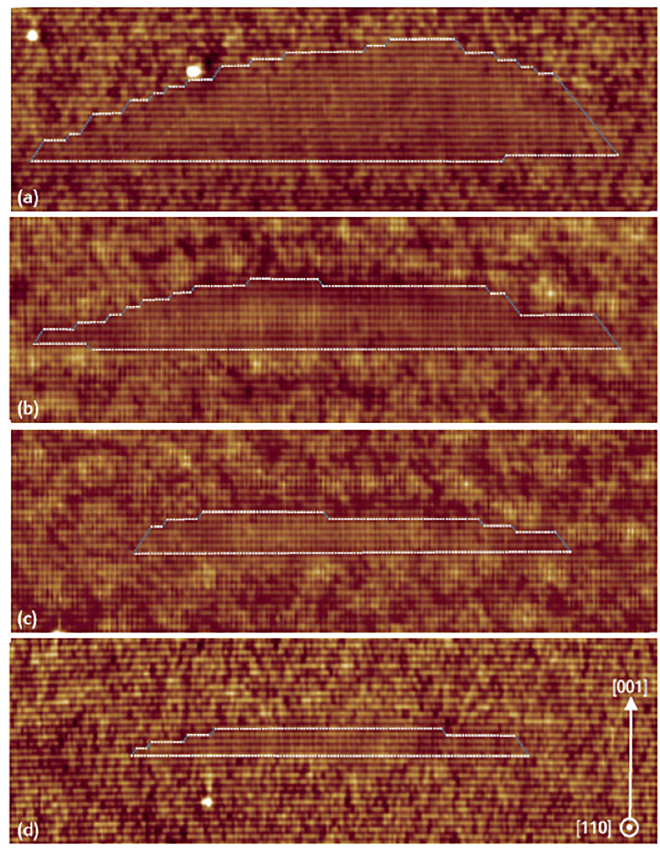
Figure 10. 53 × 17 nm 2 filled-state topography images of QDs for ( a ) 5 MLs, ( b ) 3 MLs, ( c ) 2 MLs and ( d ) 1.5 ML of Ga. The images correspond to 2D cuts close to the center of the QDs. The (110) facets are outlined in white and (111B) facets are outlined in blue. Reprinted figure with permission from Ref. [96] © 2015 by the American Physical Society.